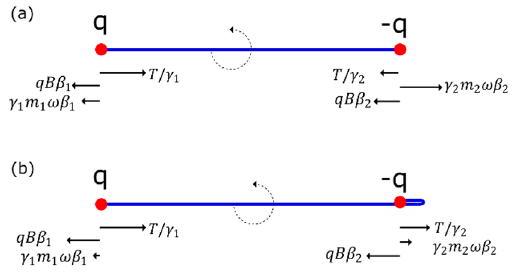
Figure 4 . The forces acting on the endpoint particles when the fold develops. The forces are drawn to scale for a solution with qB = 1 = 8 and equal endpoint masses. In (a) we take m=Te‘ = 0 : 003 ( Te‘ being equal to the energy carried by the string) and we (cid:12)nd a solution without a fold. When the masses are taken to be even smaller, m=Te‘ = 0.001 then we have only the solution with the